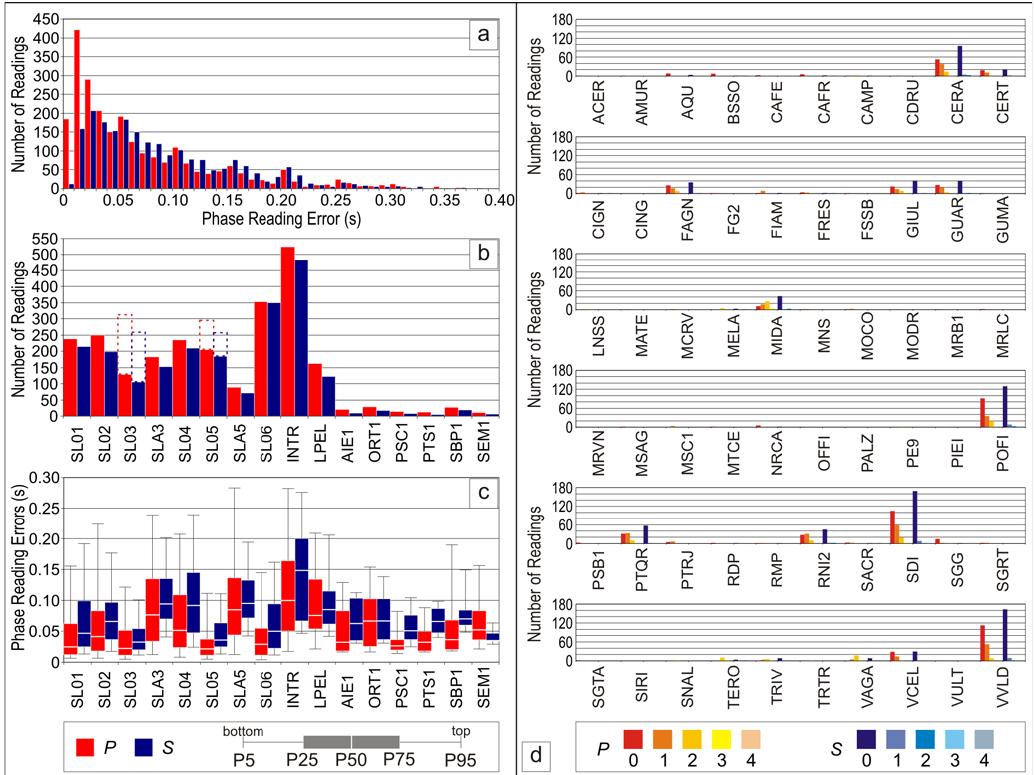
Fig. A1. Left: accuracy of pickings for all the phases read in this study. Period from 27 May to 31 December 2009. Right: weight code distribution for the RSNC stations used. (a) Number of P and S phases (in red and blue, respectively) versus reading errors. More than 90% of the pickings have a reading error less than or equal to 0.2 s. (b) Number of P and S phases identified for each station of STN and RSA networks. The dashed columns show the sum of the phases for stations SL03/SLA3 and SL05/SLA5, which correspond to different locations of the same station at nearby sites. (c) P and S reading error distribution for stations of STN and RSA networks. P5 and P95 indicate the 5th and 95th percentiles of the distribution and are represented by thin, grey bars; P25 and P75 indicate the 25th and 75th percentiles and are represented by thick, coloured bars; P50 is the median, and it is represented by the thin white line inside the thick bar. (d) P and S weight code histograms for all the 60 RSNC stations used in this study. Red and blue colour scales represent weight codes associated with P and S readings,